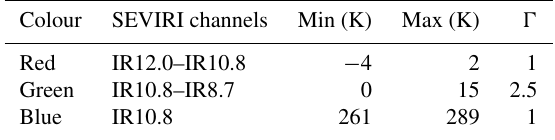
Table 1. Range and gamma ( (cid:48) ) correction for the red, green, and blue channels that construct the dust RGB